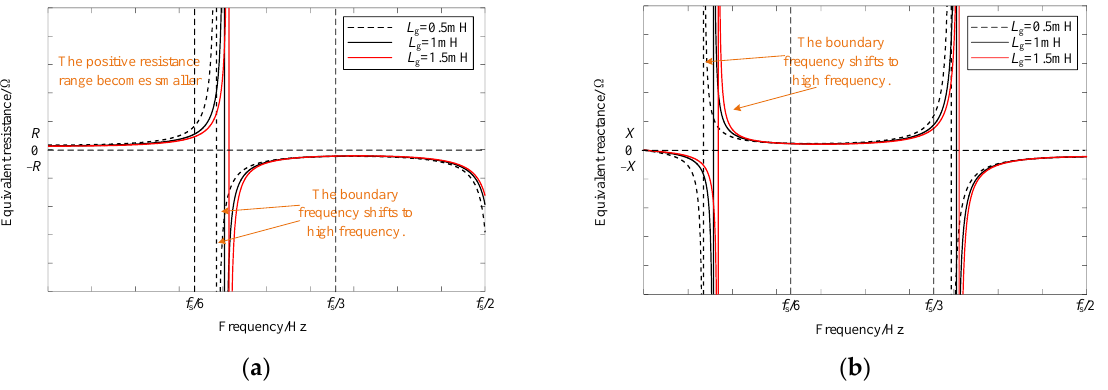
Figure 10. Frequency characteristics of virtual equivalent impedance under different grid impedance. ( a ) Frequency characteristics of equivalent resistance R eqtd ; ( b ) Frequency characteristics of equivalent reactance X eqtd .